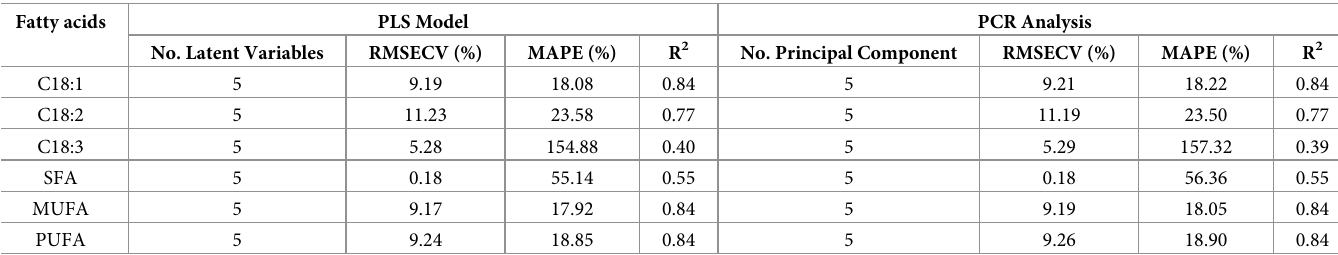
Fig 5. PCA correlation loading plot for major fatty acids, SFA, MUFA, and PUFA of vegetable oils and dielectric constant. https://doi.org/10.1371/journal.pone.0268827.g005 The PCR models gave coefficient of determination (R 2 ) values between 0.39 to 0.84 for indi- vidual fatty acids. C18:1, MUFA, and PUFA showed the most accurate results relating the pre- dicted composition to the measured composition, with an R 2 of 0.84, and MAPE of 18.05% to 18.90%. This is followed by C18:2 with an R 2 of 0.77 with slightly higher MAPE of 23.5%. Fig 6 shows the predicted values versus measured values of the PCR regression model for MUFA. The dielectric prediction model for these fatty acids’ composition gives the most accurate results because of their higher percentage of composition in the oil. Poor R 2 and very high MAPE were observed for C18:3 and SFA due to low percentage com- position in oil. Most vegetable oils contain less than 16% of C18:3, and less than 1% of SFA with reference to the total fatty acid composition, as displayed in Table 2. This echoed earlier studies whereby Akkaya et al . and Yuan et al . also recorded relatively low correlation for C18:3 and SFA [26, 33]. C18:3 and SFA are a small fraction of lipids, and their content is somewhat similar in a variety of vegetable oil. Table 5. Prediction evaluation of the PCR and PLS